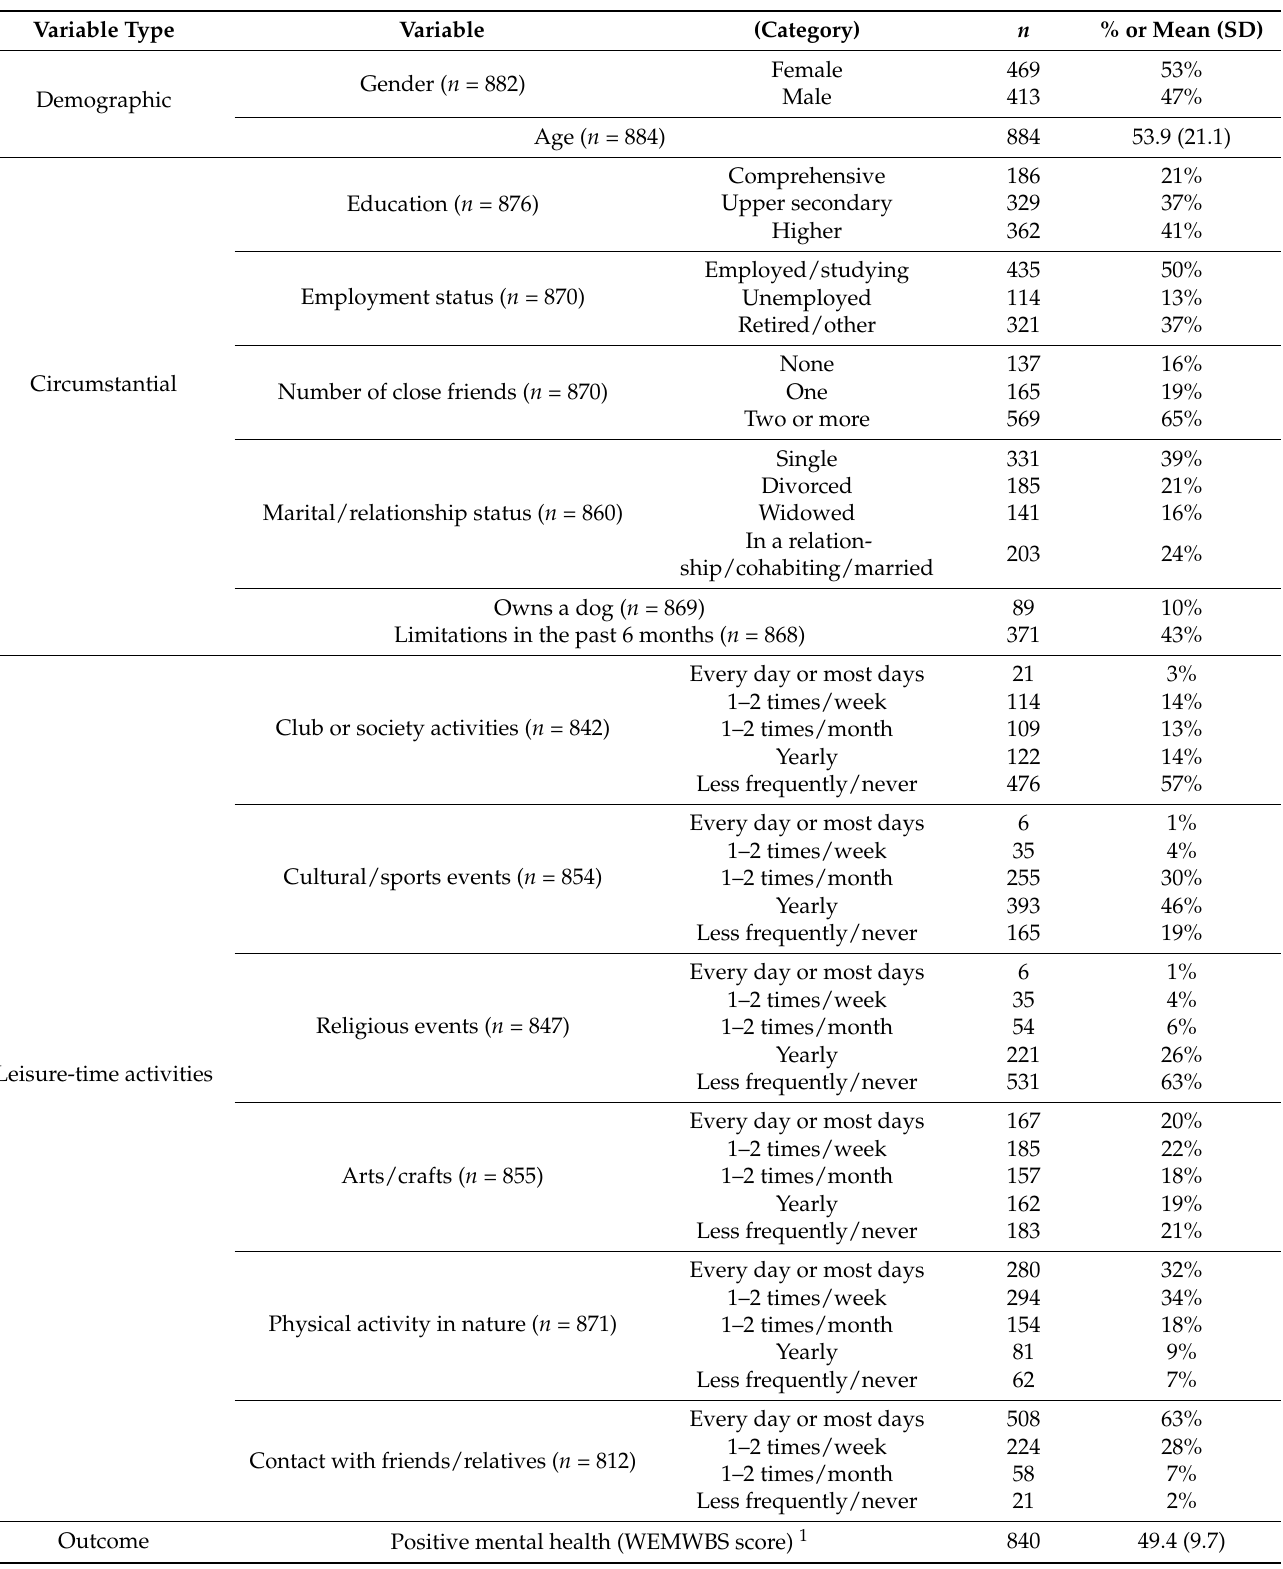
Table 1. Distributions of the study